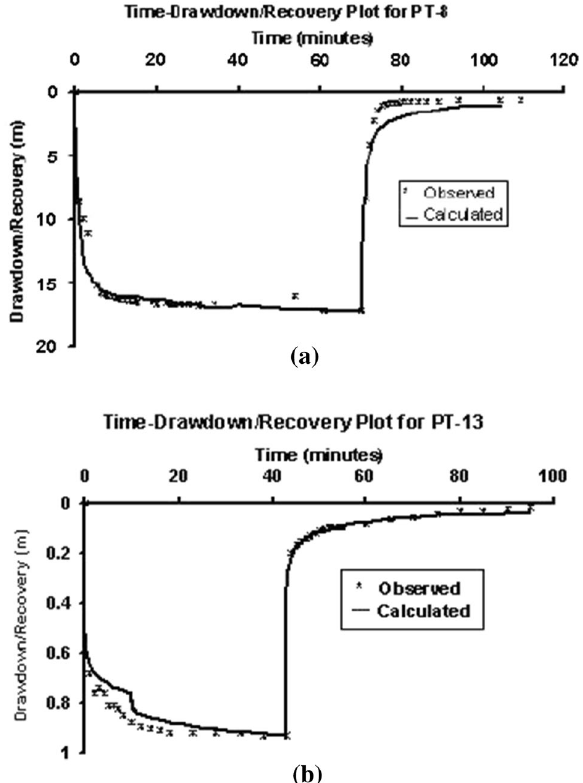
Fig. 5 Interpreted time-drawdown/recovery plot by numerical meth- ods for test in pediplain with shallow weathering (PPS) geomorpho- logic